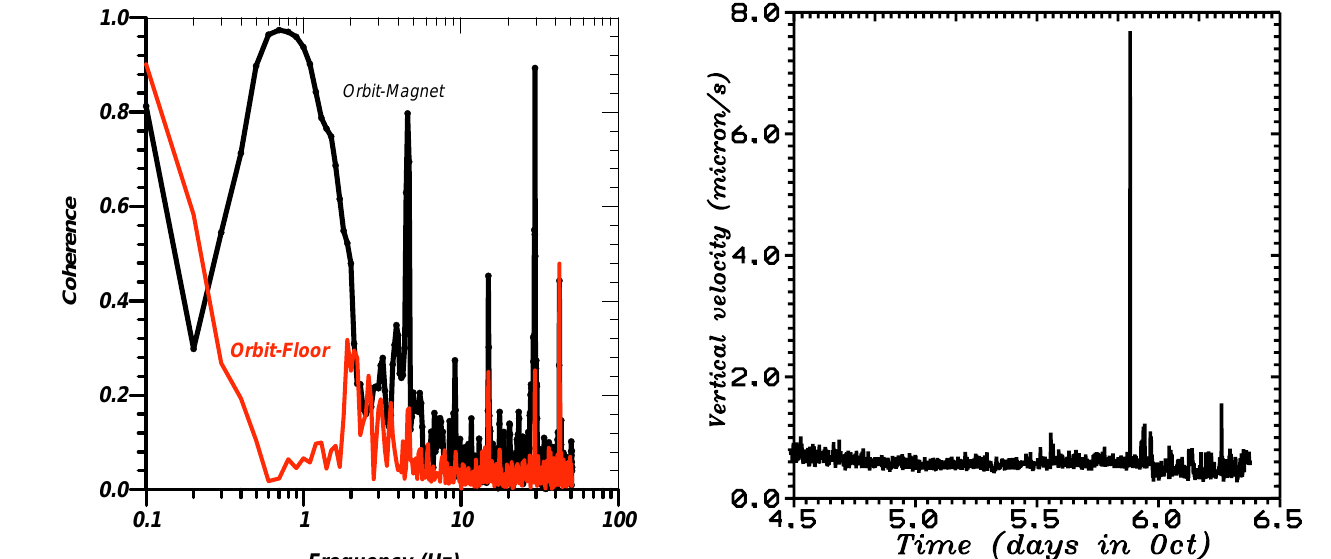
FIG. 9. (Color) Coherence between signals of the vertical Tevatron beam orbit motion and the F11 magnet vibrations (marked line) and between the orbit and the tunnel floor.